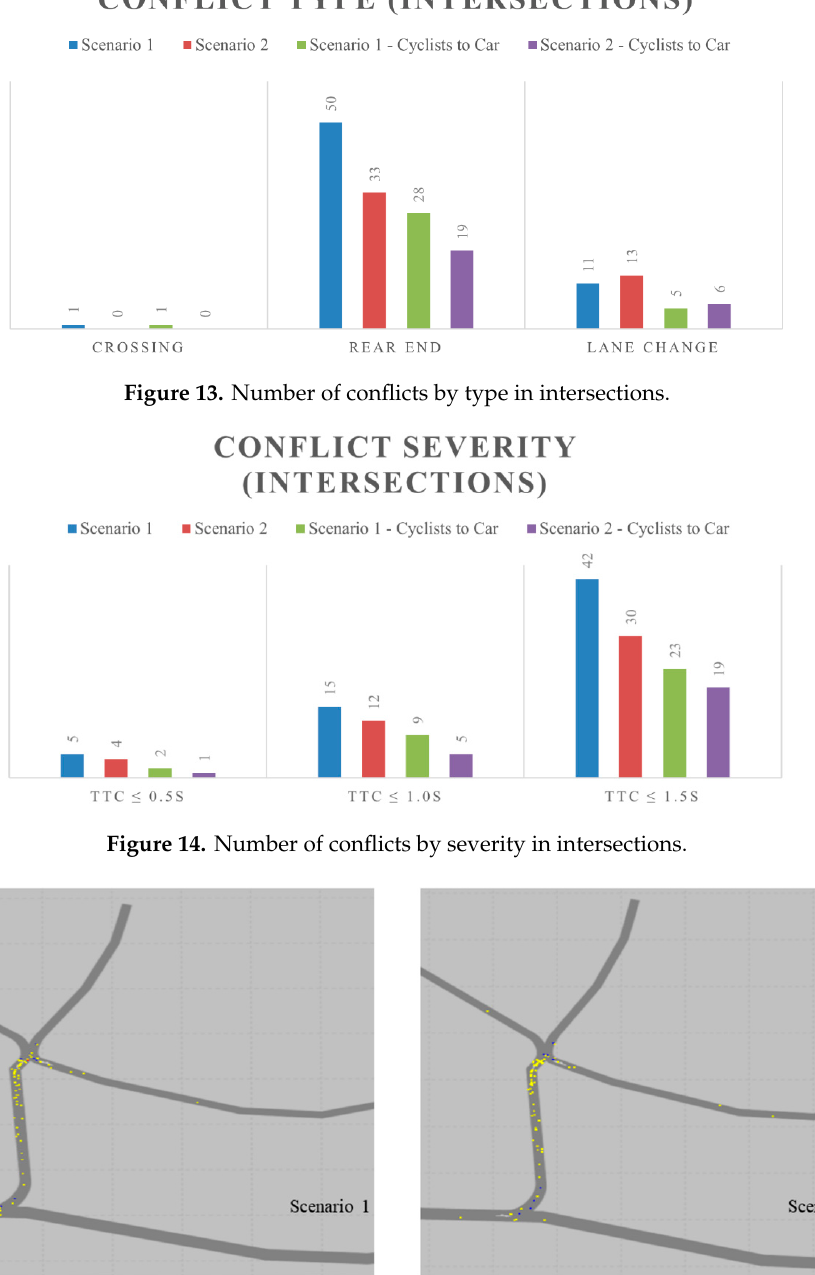
Figure 15. Conflict overview comparison of the two scenarios.